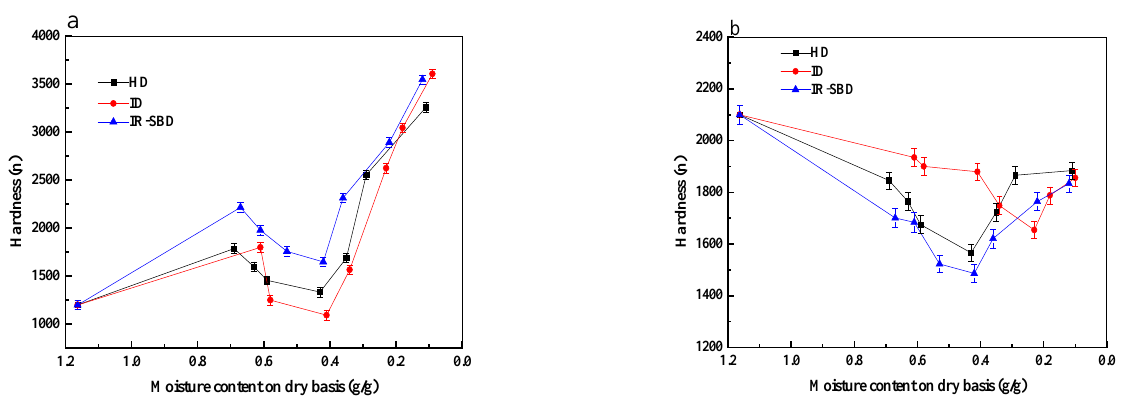
Figure 6. Hardness changes of peanut kernel ( a ) and peanut shell ( b ) during three drying methods.